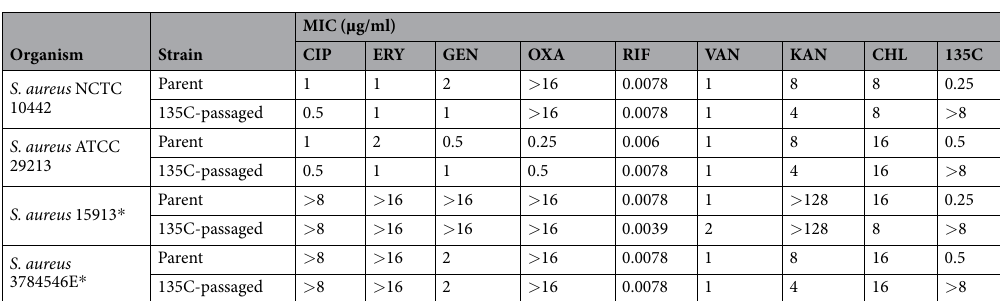
Table 4. Evaluation of S. aureus isolates passaged with 135C for cross-resistance to antibacterial agents. CHL, chloramphenicol; CIP, ciprofloxacin; ERY, erythromycin; GEN, gentamicin; KAN, kanamycin; OXA, oxacillin; RIF, rifampin; VAN, vancomycin. * Clinical isolate.